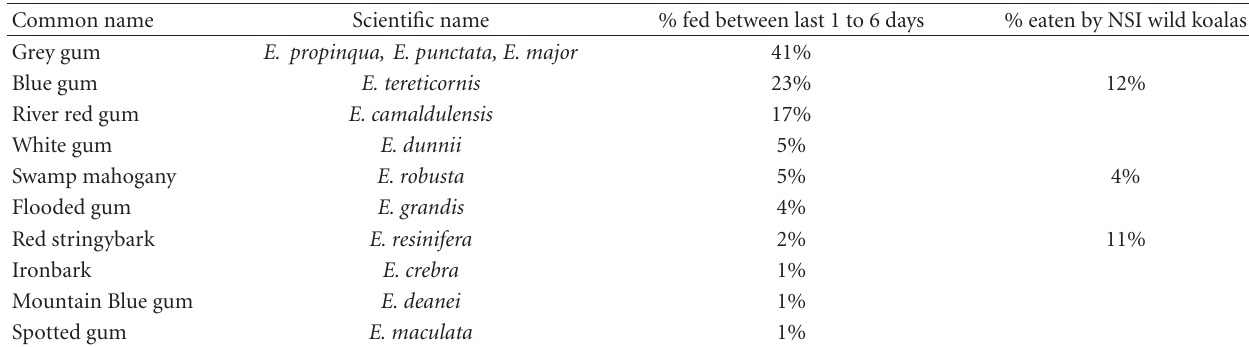
Table 2: Eucalypt species fed to hospitalised koalas between 1 and 6 days [26] before their scats were collected in comparison to species found in the diet of wild koalas on NSI (only E. tereticornis , E. robusta, and E. resinifera are present on NSI, their percentages are taken from Cristescu et al.